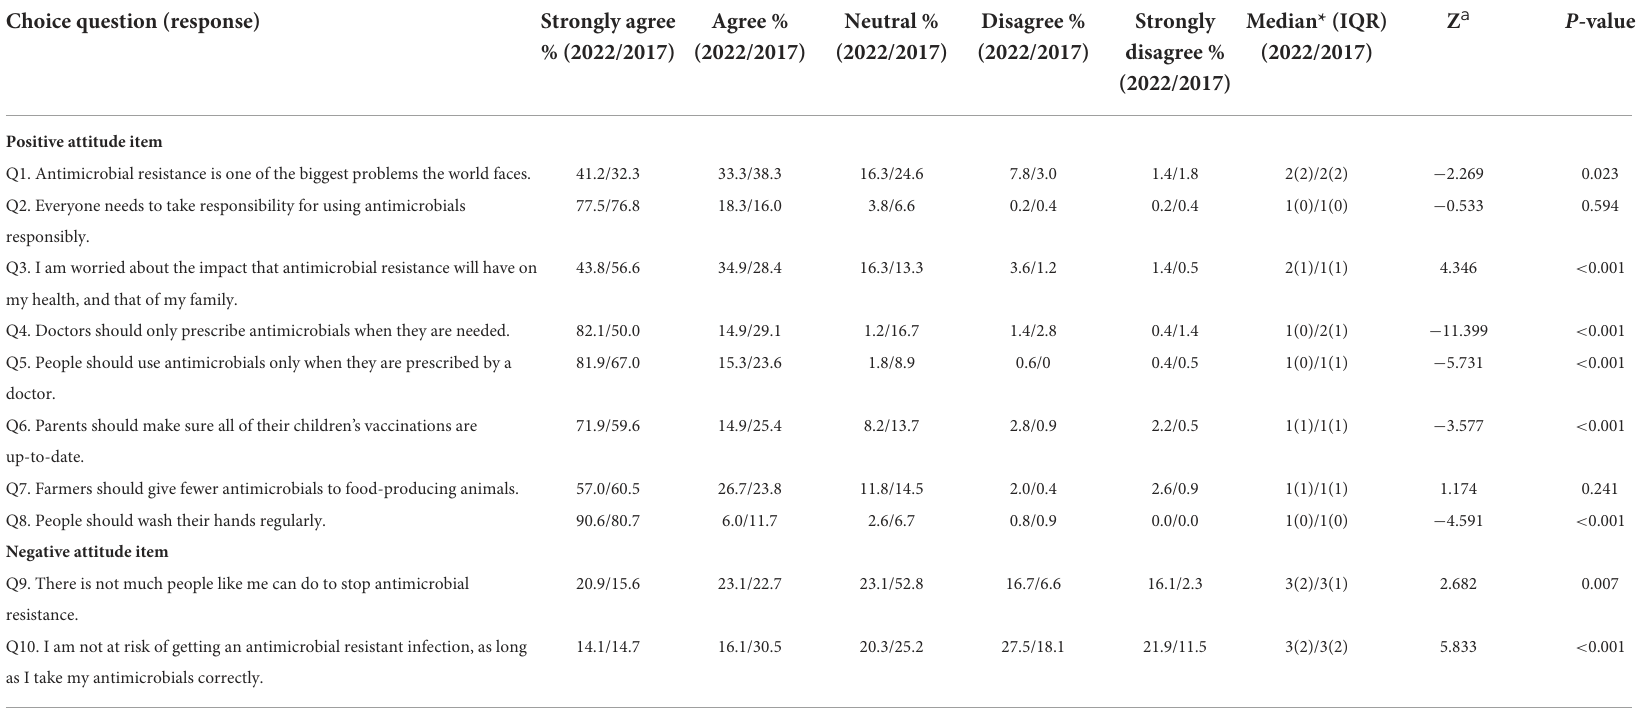
TABLE 3 The attitude of respondents regarding antimicrobials. Choice question